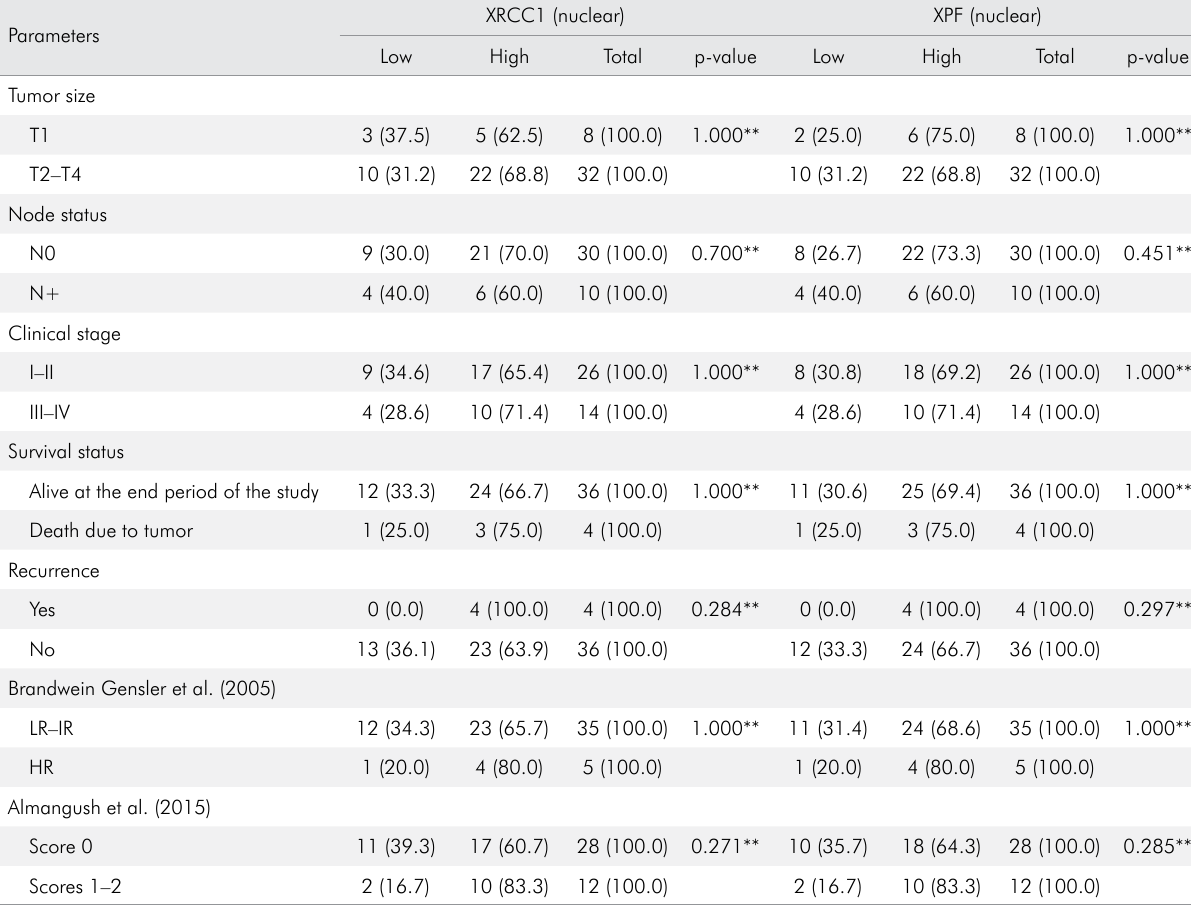
Table 3. XRCC1 and XPF nuclear expression in relation to clinicopathological findings of lower lip squamous cell carcinoma.